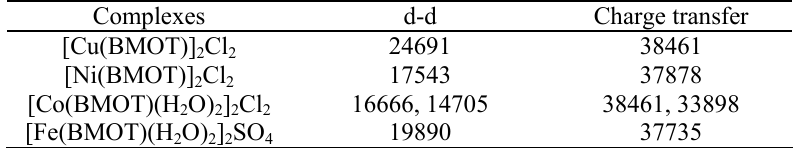
Table 2. Electronic spectral data, cm -1